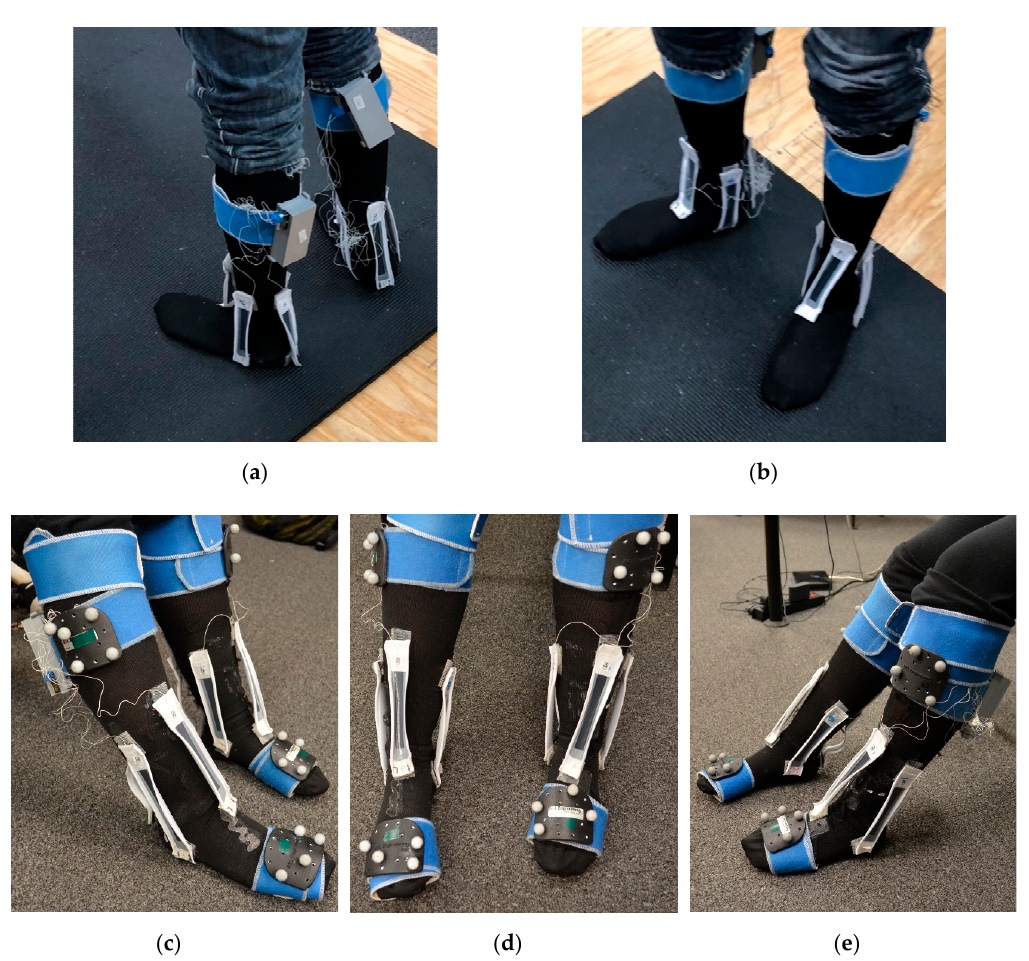
Figure 2. Soft robotic sensor placement and orientation configuration or SRS POC placement for the ( a ) left and ( b ) back for a simulated participant at rest prior to a TSP gait trial; SRS POC placement and motion capture marker set placement for the ( c ) left, ( d ) front, and ( e ) right for stimulated seated participant.